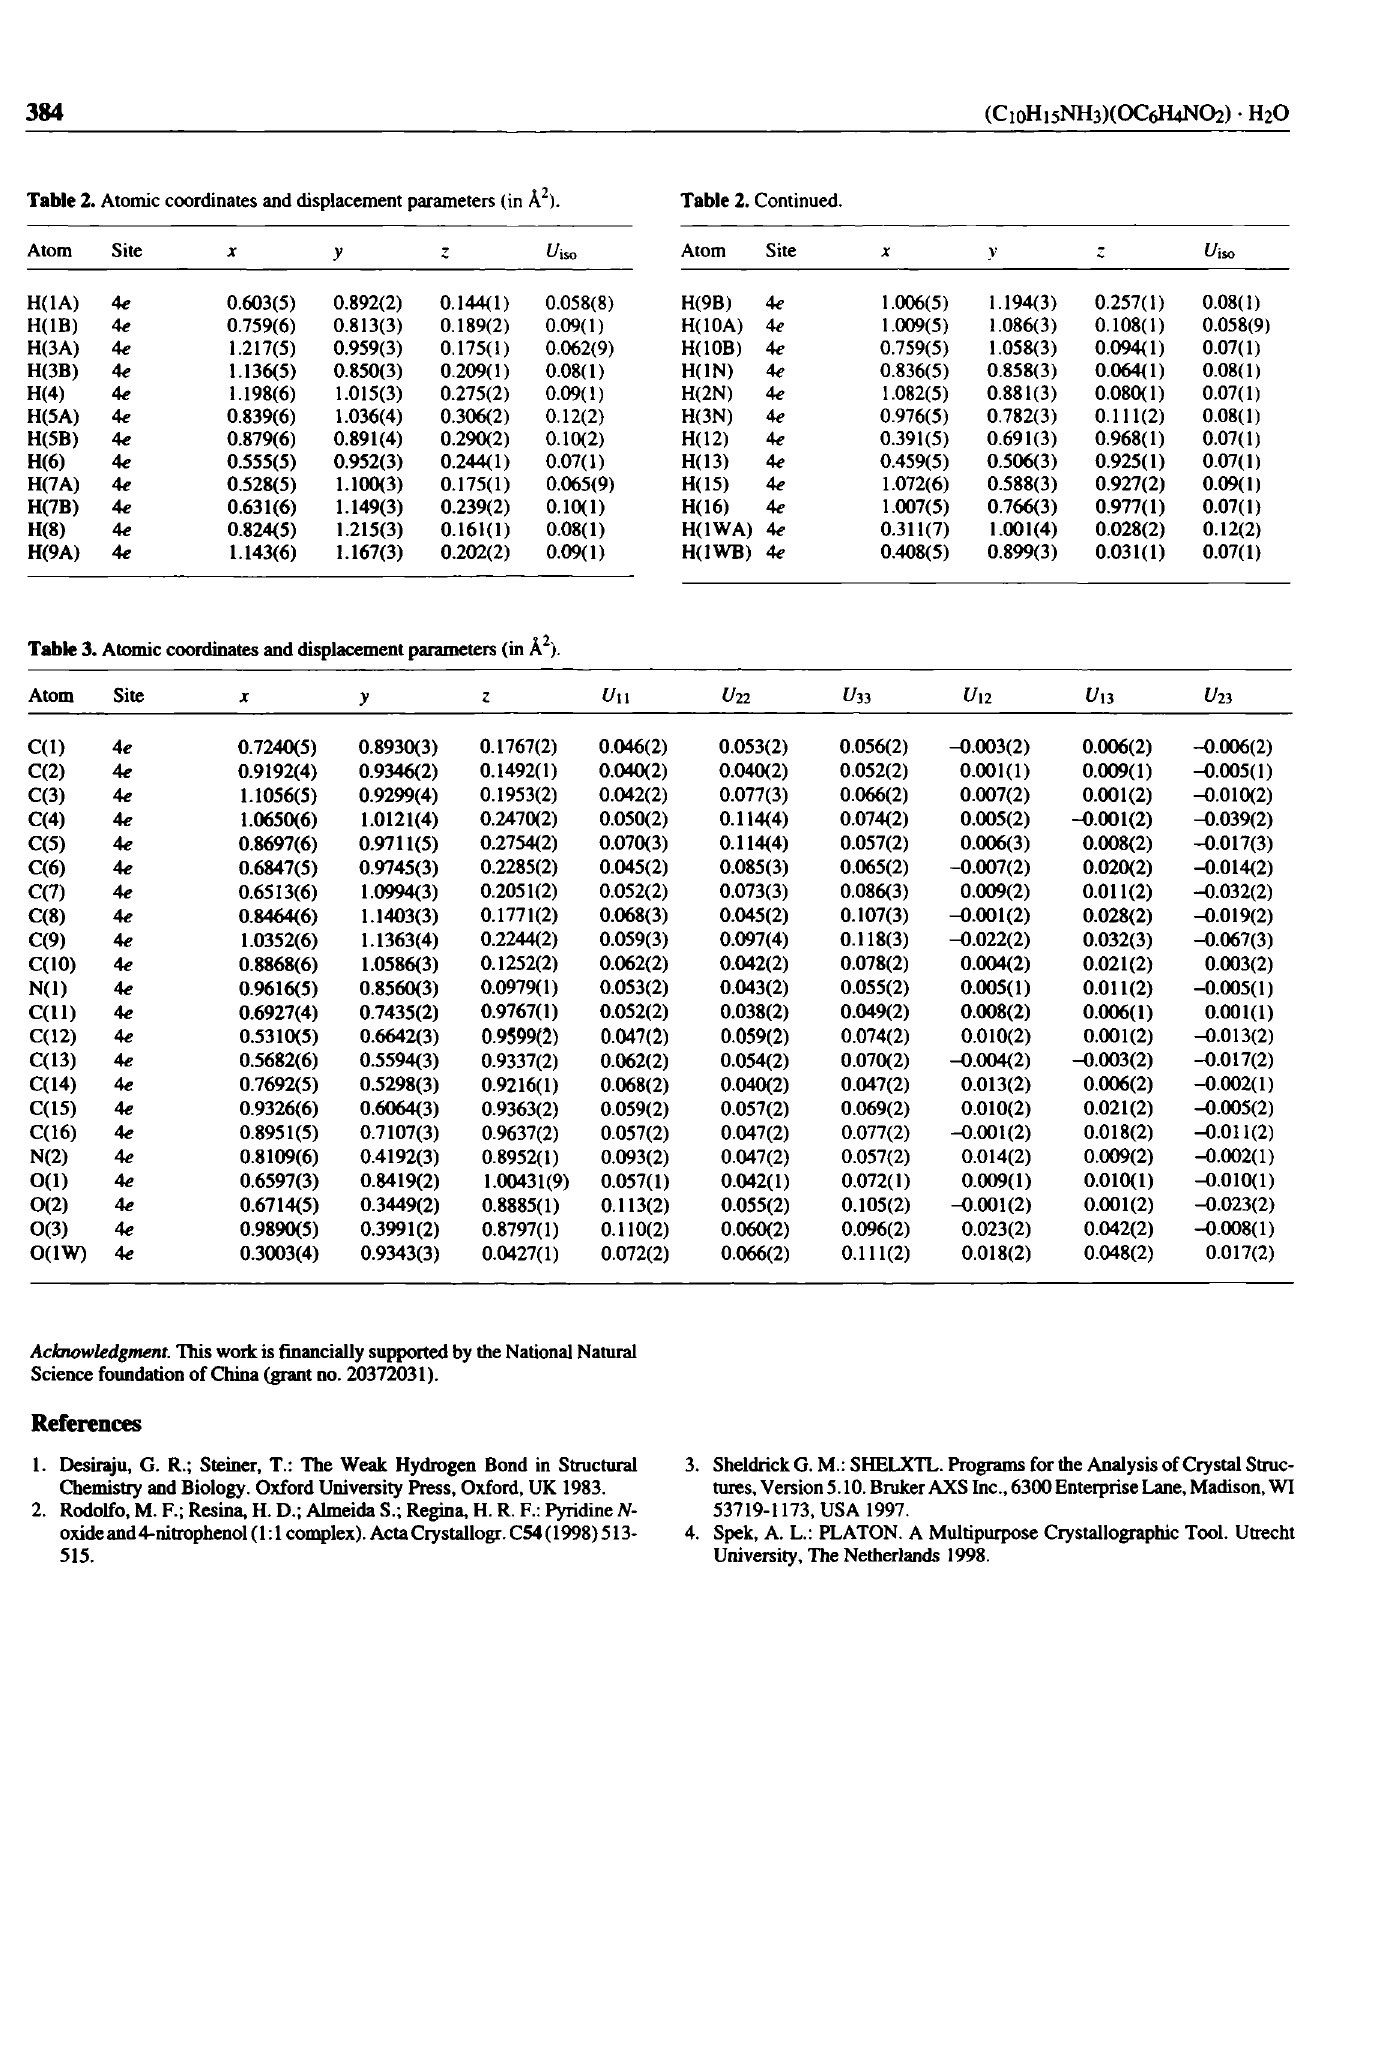
Table 3. Atomic coordinates and displacement parameters (in A 2